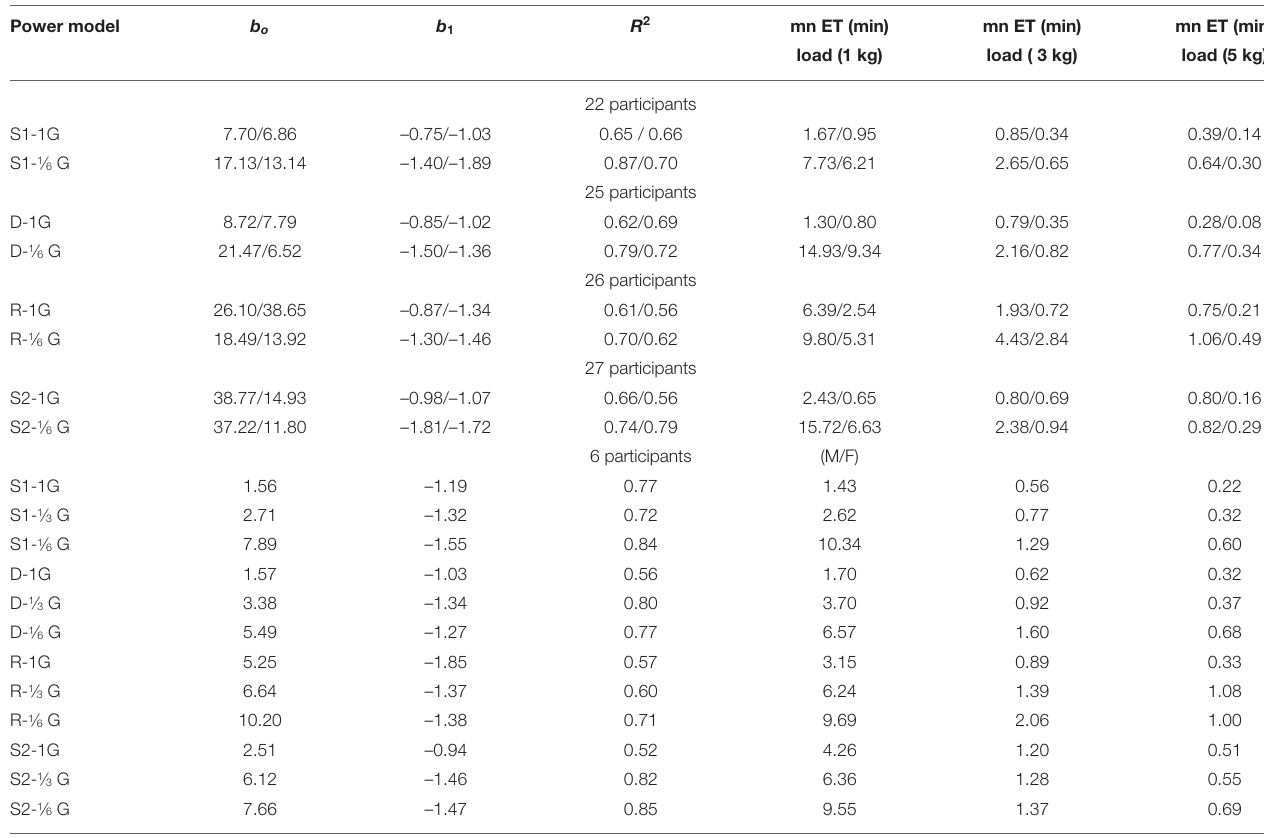
TABLE 2 | Task Intensity-Endurance time power